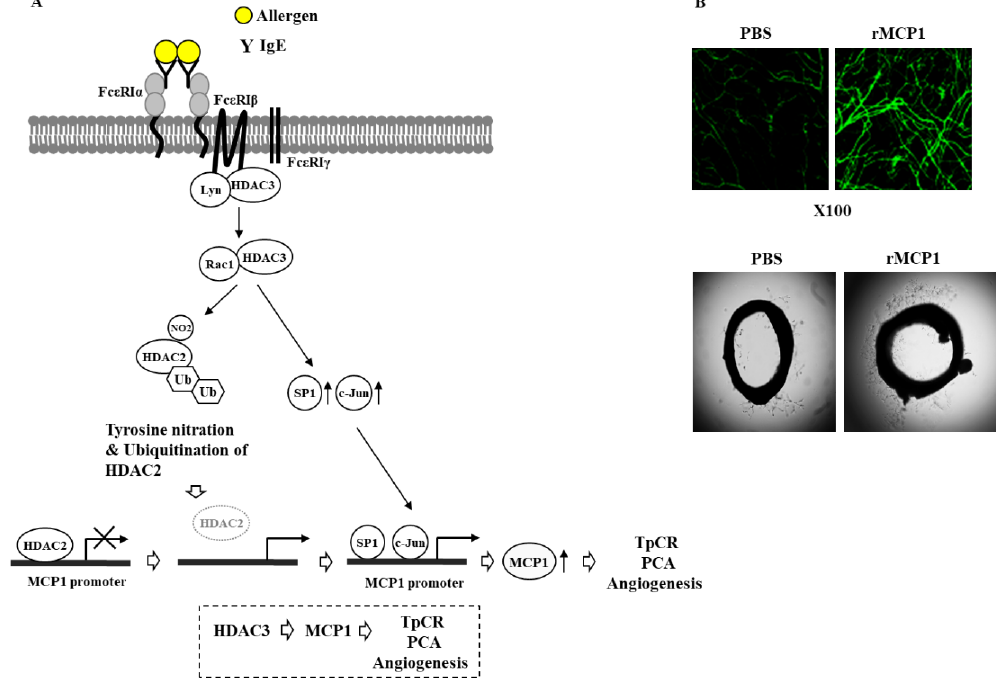
Figure 2. Histone deacetylase 3 (HDAC3) binds to Fc ε RI and mediates a triphasic cutaneous reaction (TpCR) and passive cutaneous anaphylaxis (PCA). ( A ) In the BALB / C mouse model of TpCR and PCA, HDAC3 binds to Fc ε RI. HDAC3, through the interaction with rac1, leads to the tyrosine nitration of HDAC2. HDAC3 also induces ubiquitination of HDAC2 to decrease the expression of HDAC2. HDAC3 increases the expression of SP1 and C-Jun, which bind to the promoter sequences of monocyte chemoattractant protein 1 (MCP1) to increase the expression of MCP1. In the absence of allergen stimulation, HDAC2 binds to the promoter sequences of MCP1 to suppress the expression of MCP1. ( B ) Mouse recombinant MCP1 protein displays angiogenic potential based on whole mount staining employing anti-PECAM antibody (upper panel) and aortic ring formation assays (lower panel). In conclusion, Fc ε RI-HDAC3-MCP1 signaling mediates TpCR, PCA and angiogenesis. The ↑ arrows denotes increased expression level and → arrows denote activation of transcription and positive regulation. Hollow arrows denote positive